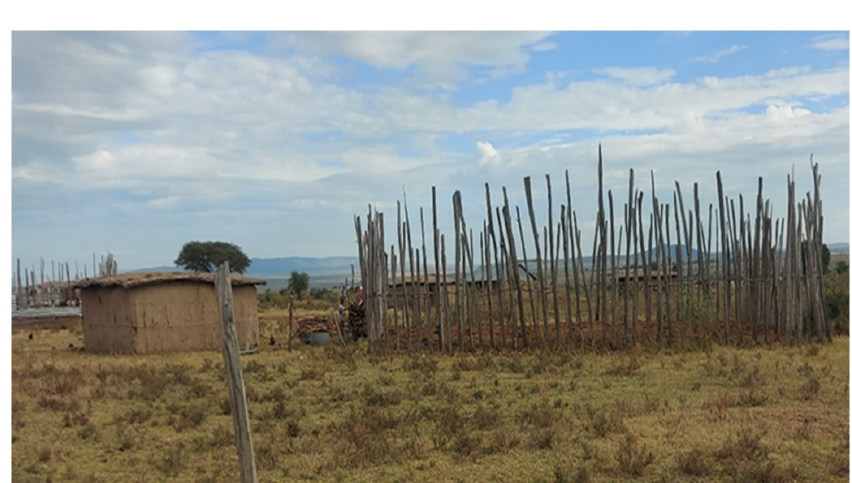
Figure A1: Traditional Kraal build using posts.